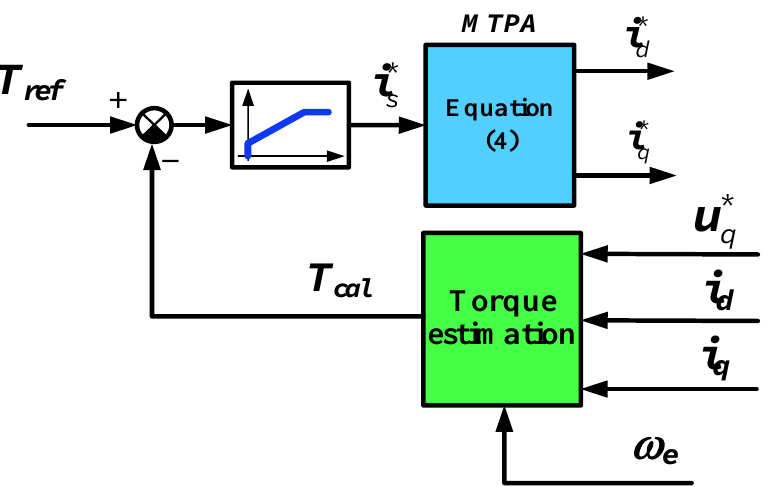
Figure 21. Comparison experiment block diagram based on classical formula MTPA.